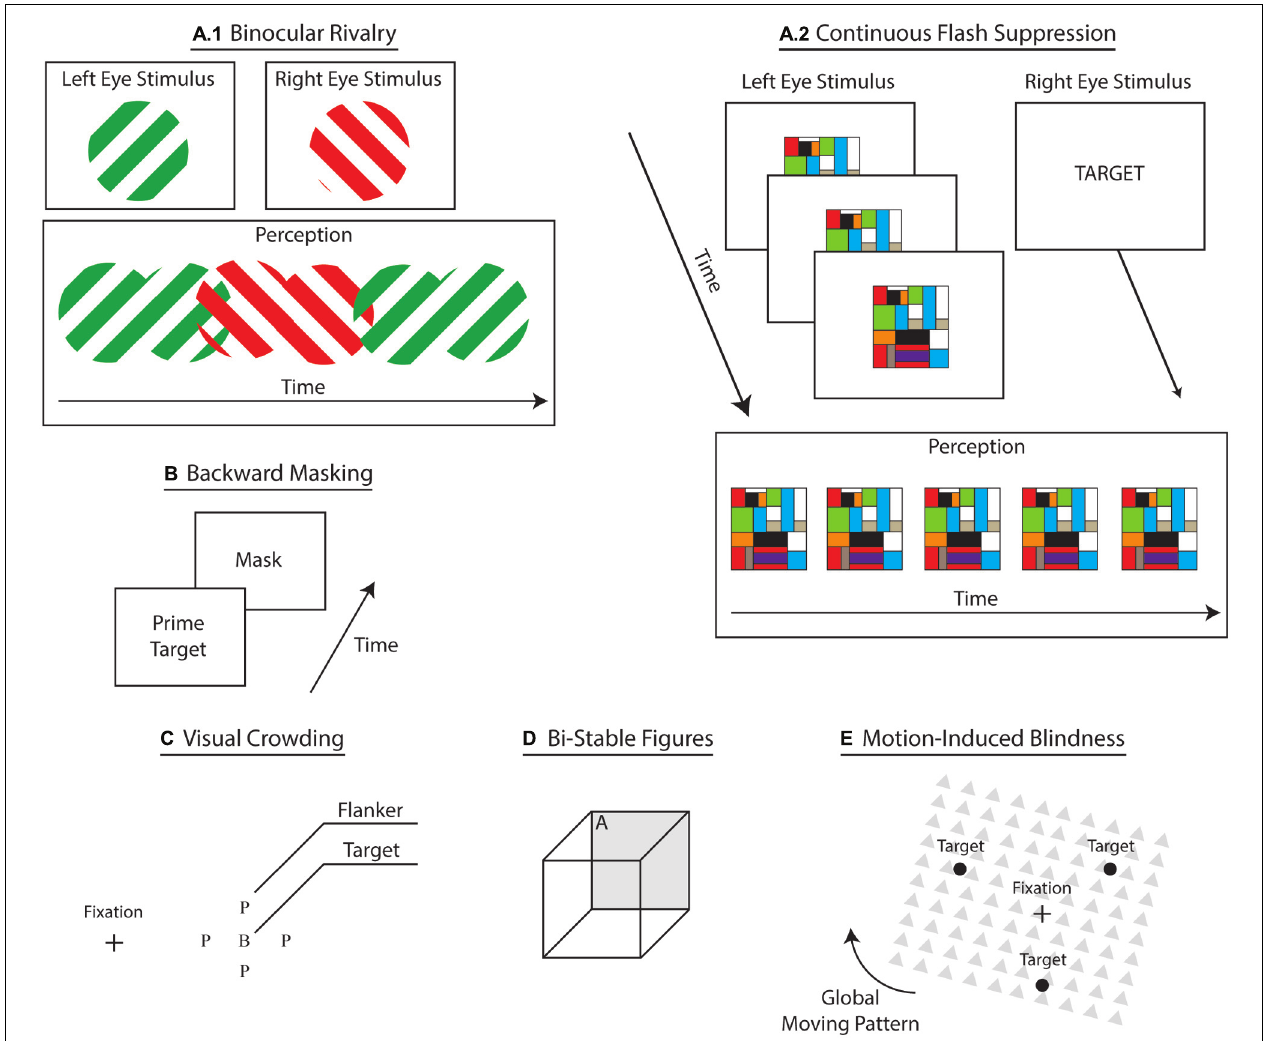
and a mask conscious induces conscious suppression of the prime. (C) Visual crowding where flankers interfere with processing of the target in peripheral vision, rendering certain target-related characteristics unrecognizable. (D) Bistable figures induce perceptual fluctuations between mutually exclusive visual interpretations – e.g., side A facing upward and then facing downward. (E) Motion-induced blindness where movement of the global pattern suppresses conscious perception of the